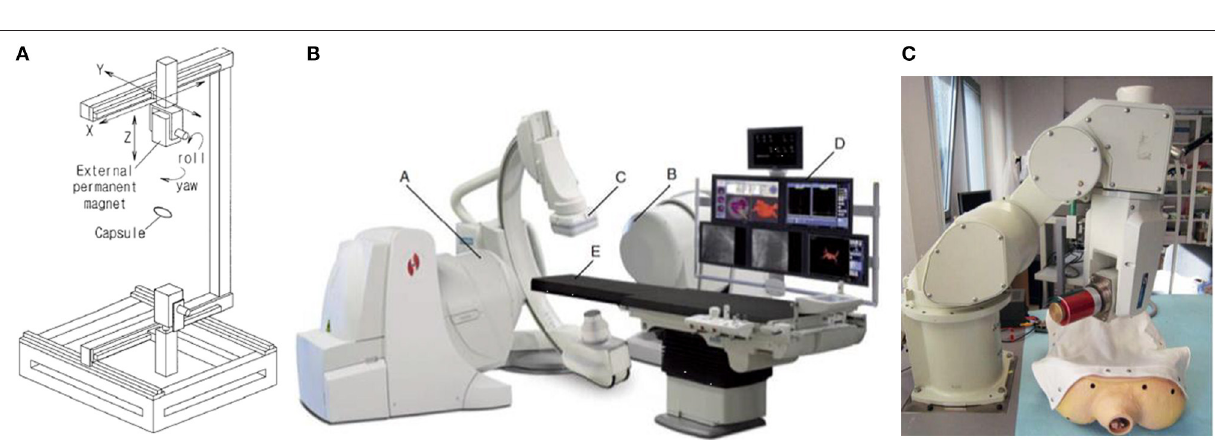
FIGURE 5 | (A) Single permanent magnet device to perform 2-DOF rotation of the external permanent magnet through the joint unit and move the external permanent magnet in the three XYZ directions through cartesian coordinate robot (Kim et al., 2008) (B) Stereotaxis Niobe magnetic control system, including two independently rotating permanent magnets (Carpi and Pappone, 2009b) (C) External permanent magnet control system in which permanent magnet is moved by a mechanical arm with 6-DOF ( Ciuti et al.,